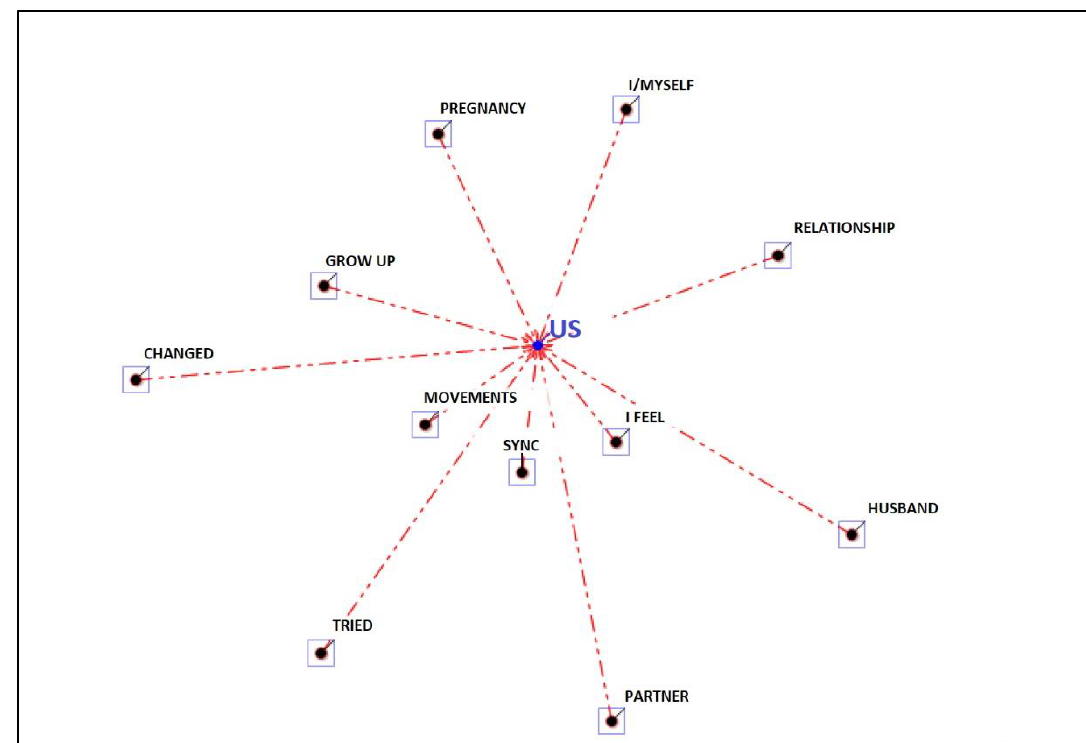
Figure 5. Associations to the theme “perception of self and with other significant”.